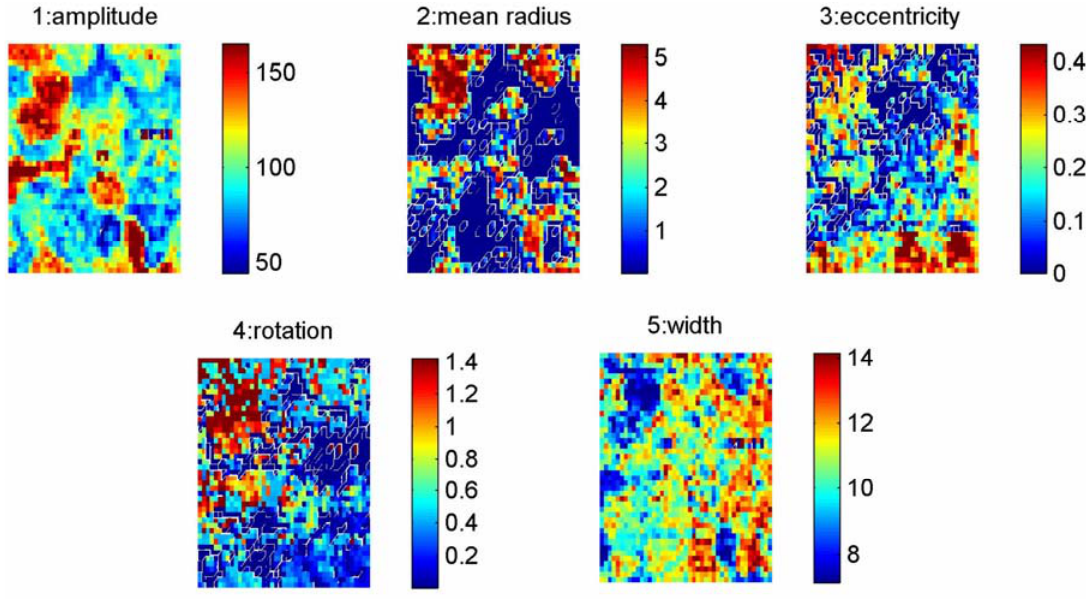
Figure 5. Represents an example of the FFT processing of the selected windows where different parameters such as, 1. amplitude, 2. radius, 3. eccentricity, 4. rotation and 5. width of the spatial correlation spectrum, could be